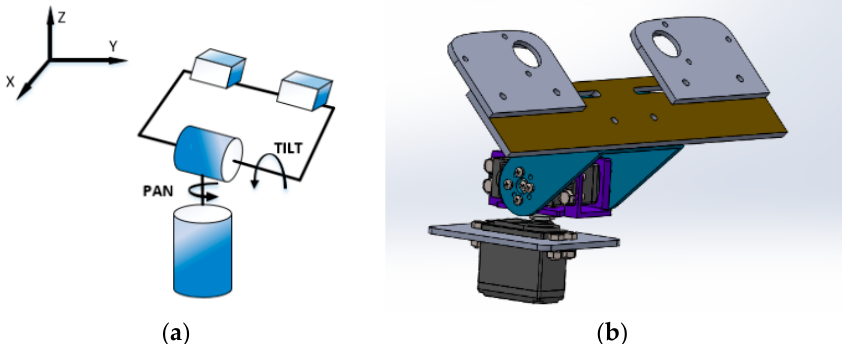
Figure 10. The pan-tilt mechanism for the digital camera: ( a ) theoretical design, and ( b ) 3D design.